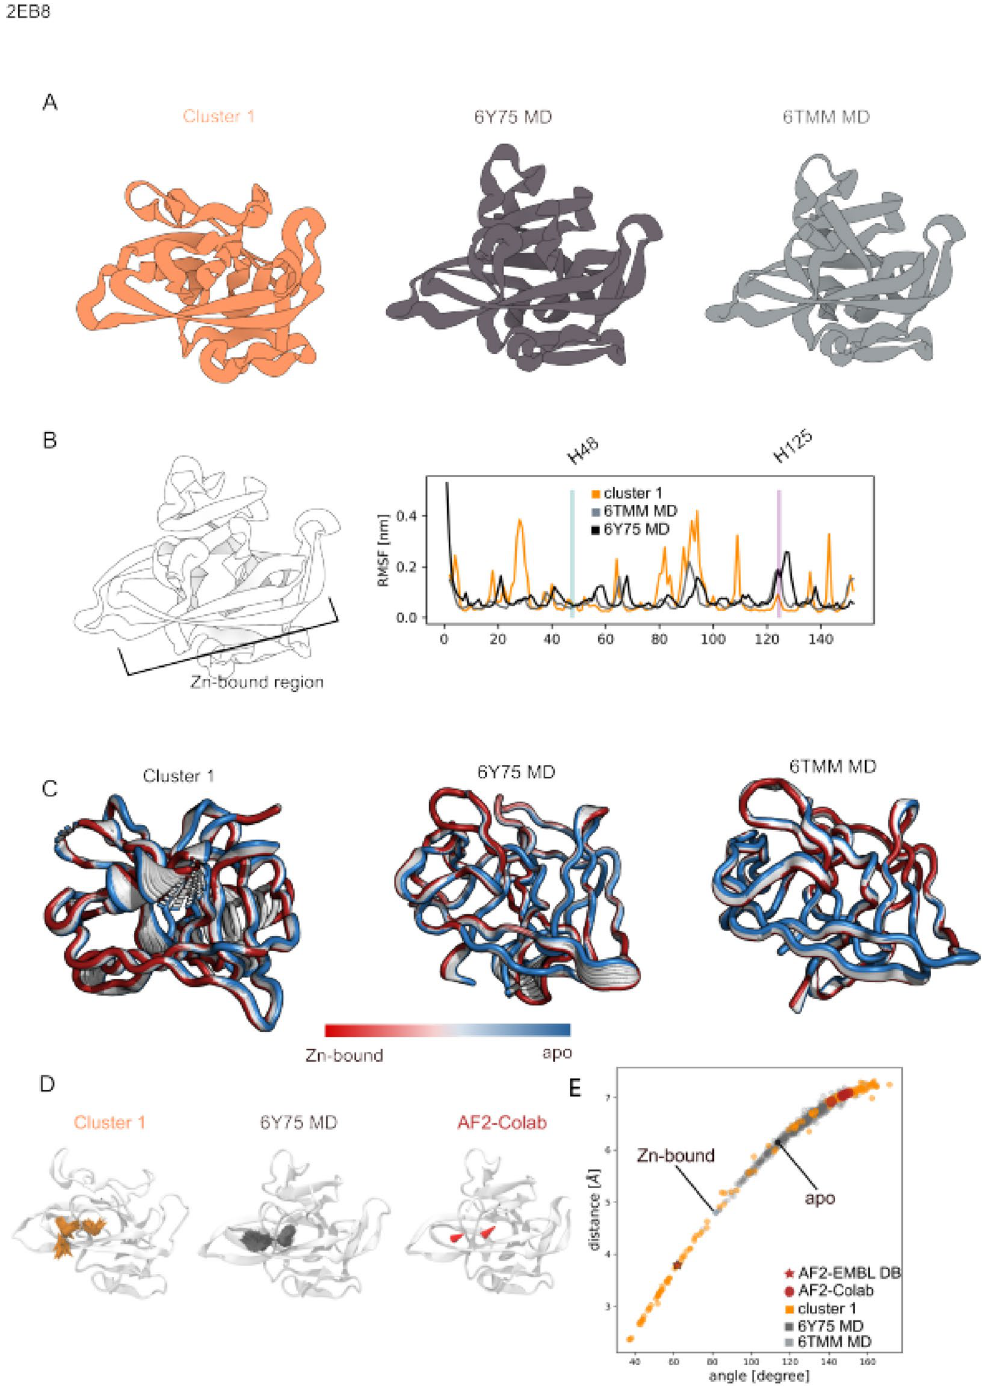
Figure 5. Tetrahymena thermophila-BIL2. ( A ) Cartoon representation of the cluster centroid (orange), 6Y75-MD snapshot (dark-grey) and 6TMM-MD snapshot ; ( B ) Root Mean Square Fluctuation (RMSF) analysis shows H48 rigidity for both the cluster (orange) and the experimental structures (6Y75 in dark grey; 6TMM in light-gray). The H125 flexibility is lower for cluster-1 compare to 6Y75 and 6TMM; ( C ). Principal Component Analysis for cluster-1 and MD simulations highlighted the protein internal movement showing a cluster-1 (orange) flexibility comparable to both 6Y75-MD (dark-gray) and 6TMM-MD (light gray); ( D ) Graphical representation of the H48 and H125 orientations for cluster-1 (orange); 6Y75-MD (dark-grey) and Google Colab predictions (red); ( E ) distance/angle correlation analysis of cluster-1 (orange) overlap with the conformational space explored by both the Zn-bounded 6Y75-MD and apo 6TMM-MD conformation respectively. AlphaFold2 prediction from EMBLDB was not public available. AlphaFold2 prediction from EMBLDB (red star) and Google Colab (red spheres) are also reported. The Zn-bounded and apo Tetrahymena thermophila-BIL2 conformations are specified with a black dot. The images were generated using 3D protein imaging webserver (https:// 3dpro teini maging. com/ prote in-